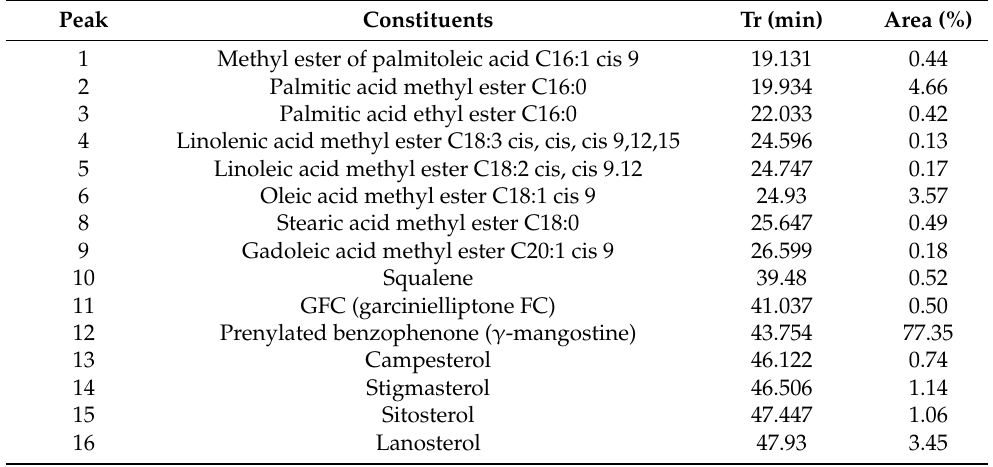
Table 1. Chemical constituents (%) hexanic extract of the seeds of P. insignis Mart.